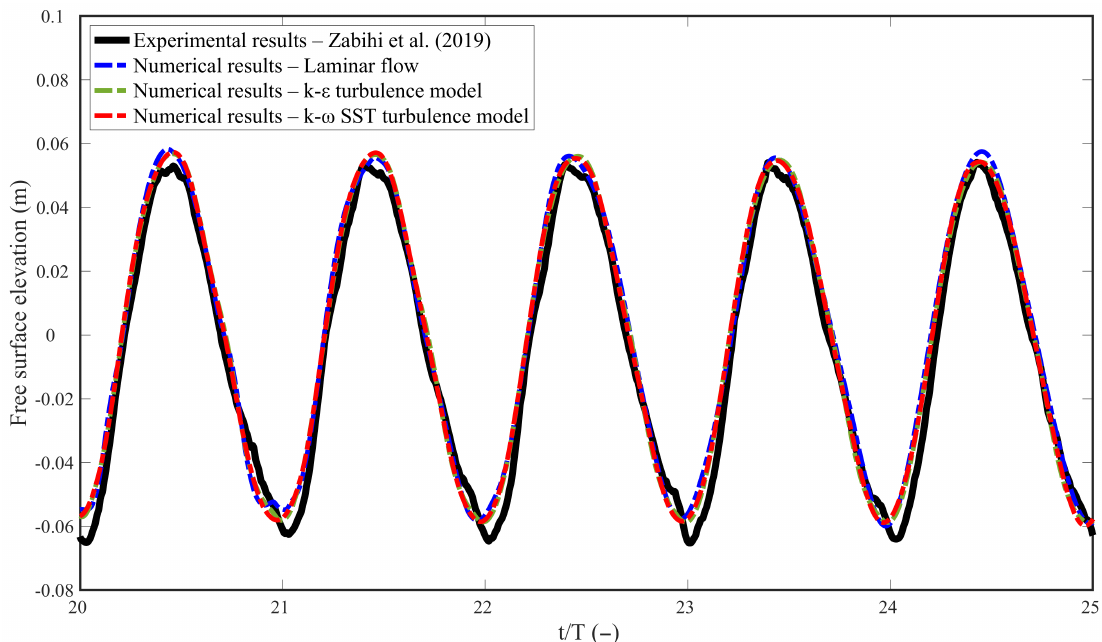
Figure 17. Free surface elevation at wave gauge WG4, located inside the hydropneumatic chamber. Experimental versus numerical